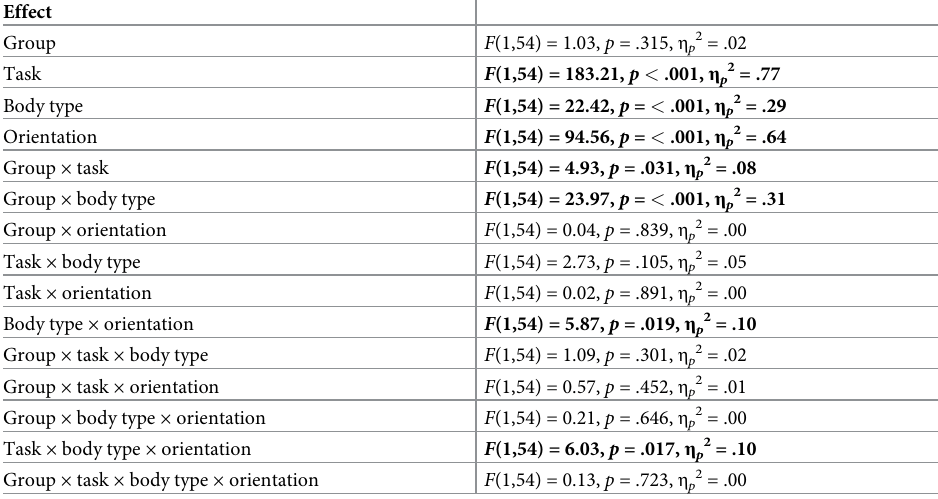
Table 1. Behavioural results: Main effects and